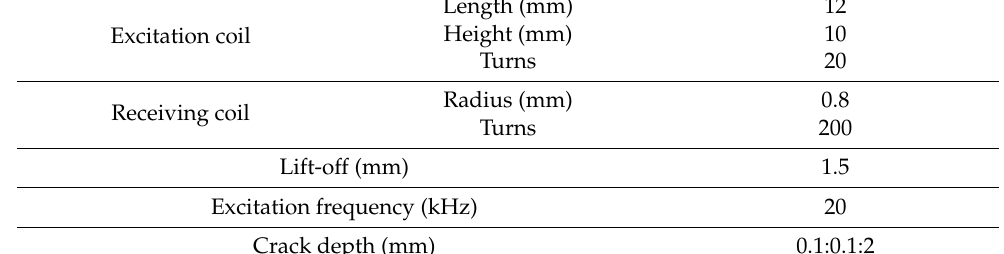
Figure 9. The orientation of the sensor probe at 0° and 90°.